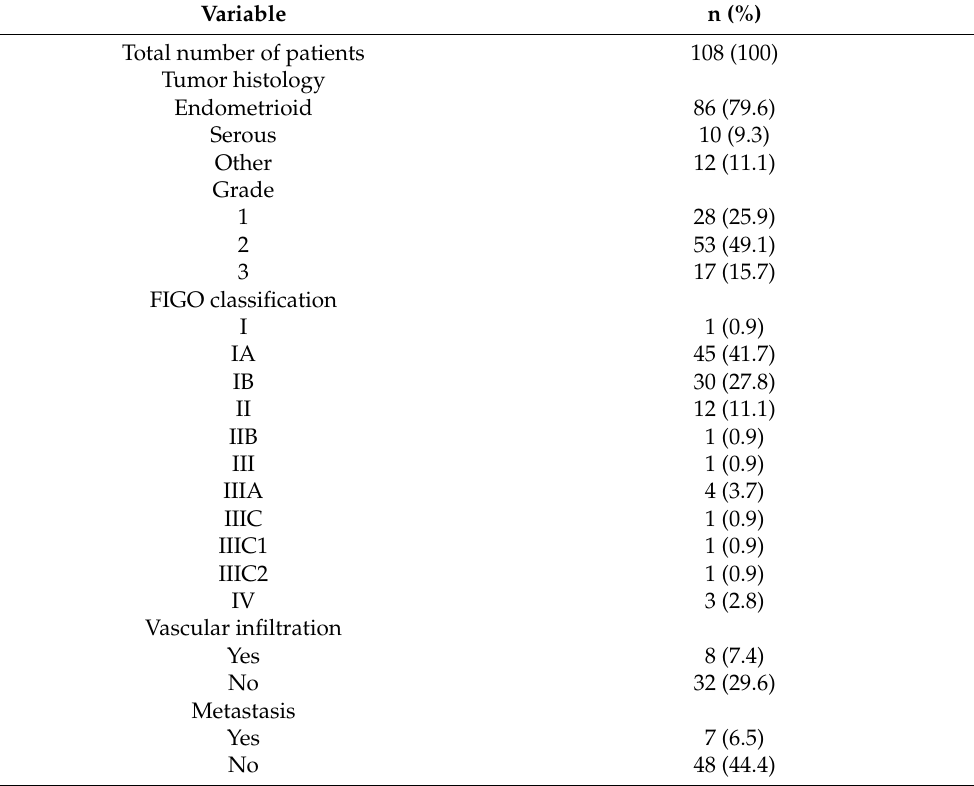
Characteristics of endometrial cancer and sarcoma patients in terms of selected prognostic